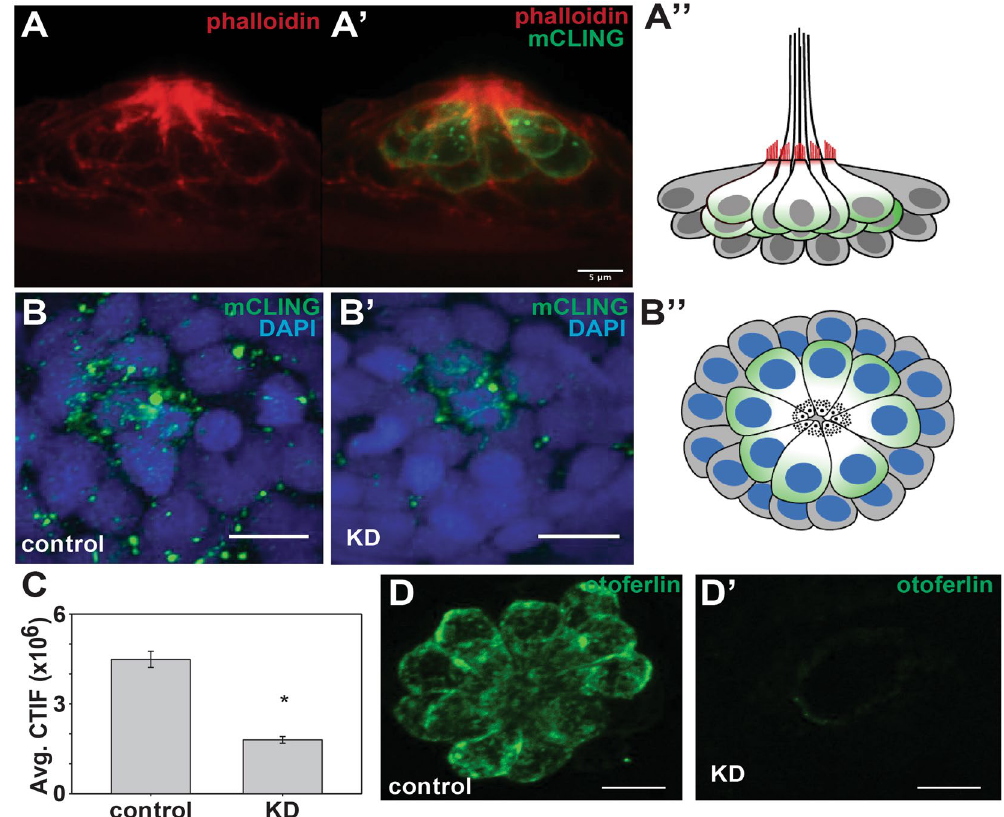
Figure 1. Depletion of otoferlin results in reduced hair cell vesicle recycling. ( A – A ’) Representative confocal images of 96 hpf ( A ) phalloidin stained neuromasts and (A’) phalloidin and mCLING stained neuromast viewed laterally. ( A” ) A diagram of a neuromast viewed laterally, with phalloidin stained actin denoted in red, and mCLING loaded hair cells denoted in green. Support cells are depicted in grey. ( B – B ”) Representative confocal images of control morpholino injected ( B ) and otoferlin morphant injected ( B ’) lateral line neuromasts labeled with DAPI (blue) and mCLING (green) of mCLING incubation at room temperature. ( B ”) A diagram of a neuromast in the same orientation as B, B’, with DAPI denoted in blue, and mCLING loaded hair cells denoted in green. Support cells are depicted in grey. ( C ). Quantification of average mCLING dye associated with neuromasts of negative control injected and morphant zebrafish (t-test, p < 0 . 001 ). N = 6 larvae, 3–6 neuromasts per larvae for both negative control and morphant. ( D – D ’) Representative images of lateral line neuromasts stained for otoferlin (green) under ( D ) control injected and ( D ’) morpholino injected conditions. Scale bars = 5 µ